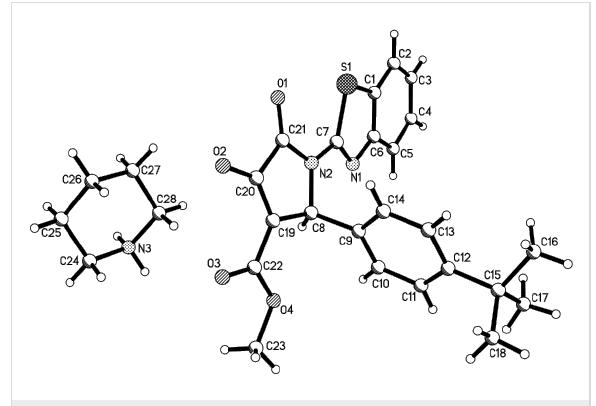
Figure 3: Molecular structure of compound 2h